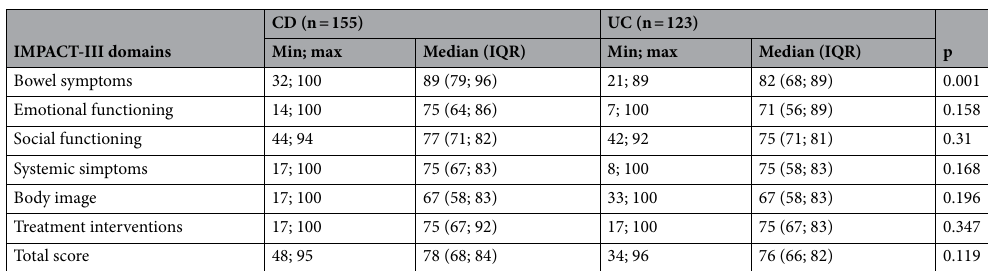
Table 4. Health-related quality of life according to type of disease. The total and single domain scores range from 0 to100, with 0 indicating the lowest HRQoL and 100 indicating the highest HRQoL. p-value refers to